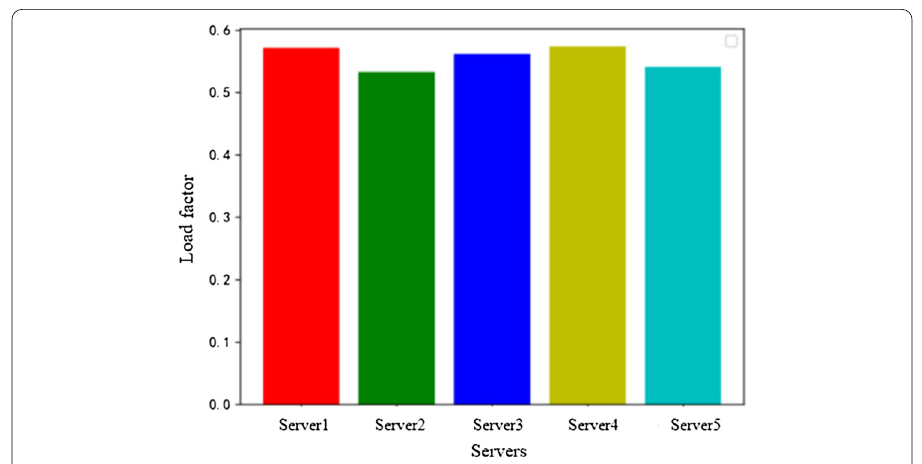
Fig. 8 Edge server load